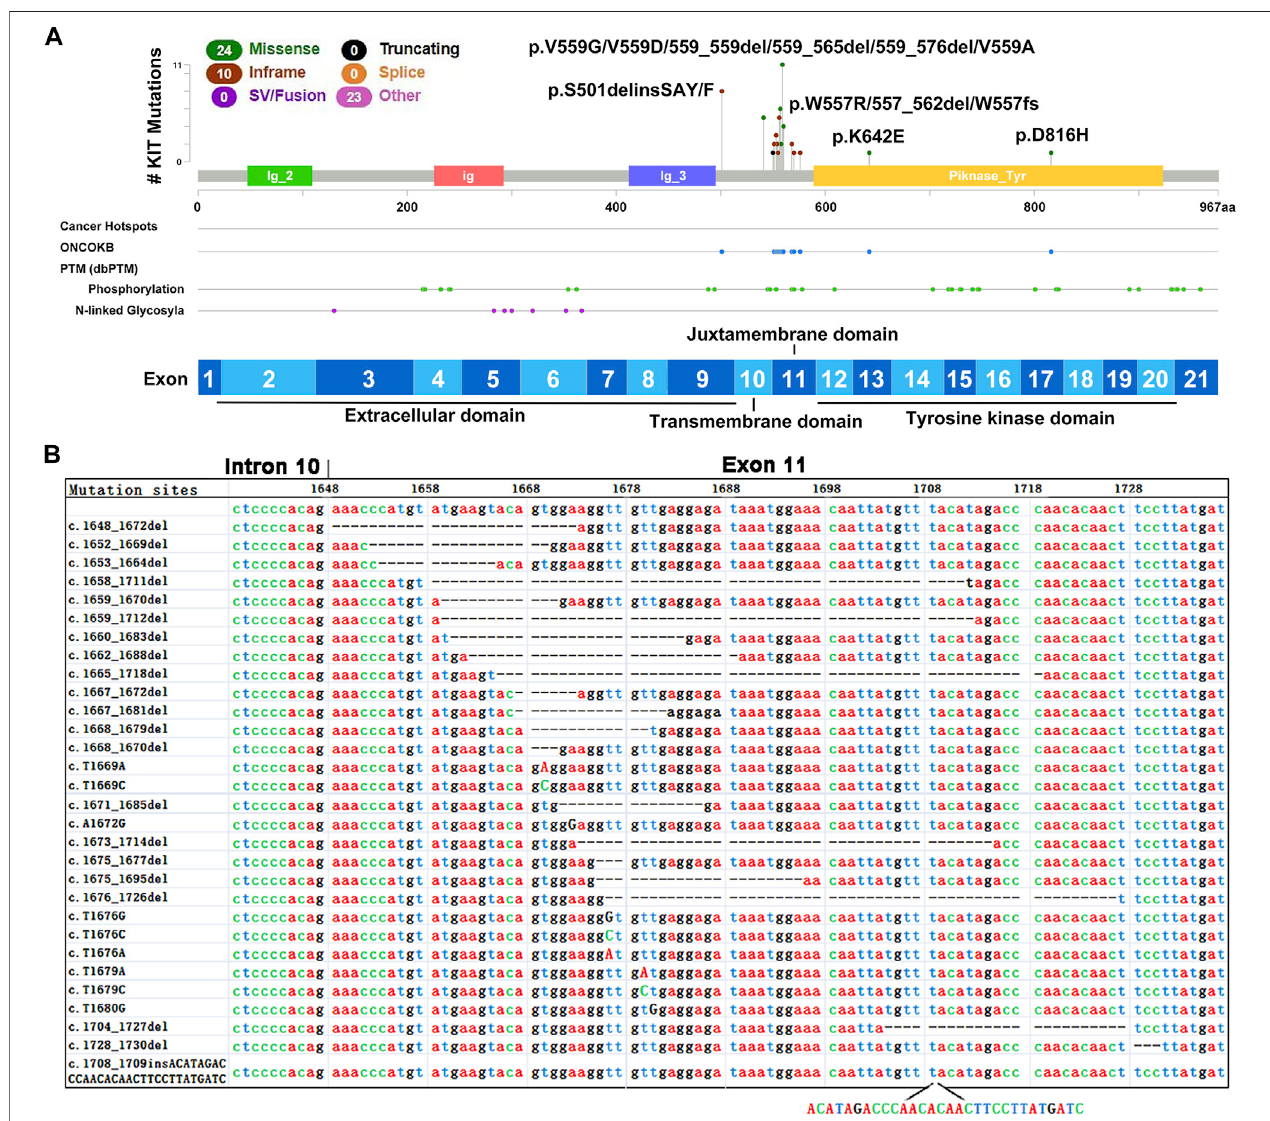
FIGURE 2 | Mutations identi fi ed in exon 11 of KIT in GIST tumors. (A) The lollipop of mutations in KIT . (B) Mutations identi fi ed in exon 11 of KIT in 49 GIST tumors.